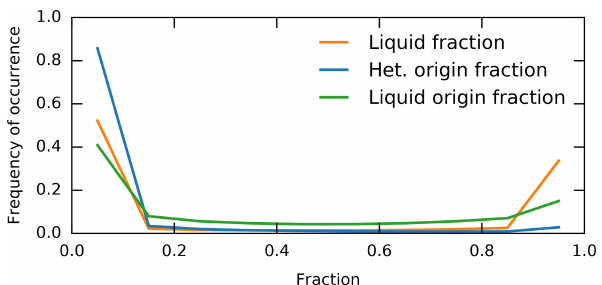
Figure 9. Frequency of cloud occurrence per ice source fraction for the liquid origin fraction F liq and the different ice source frac- tions F het and F liq − o . The histogram bin width is 0.1. The lines are aligned with bin centres. Only grid boxes are sampled where all the fractions are well-defined, i.e. only cloudy grid boxes for F liq and only grid boxes containing ice for F het and F liq − o . Data are sam- pled every time step for 10 years of simulation with the new model (2M).